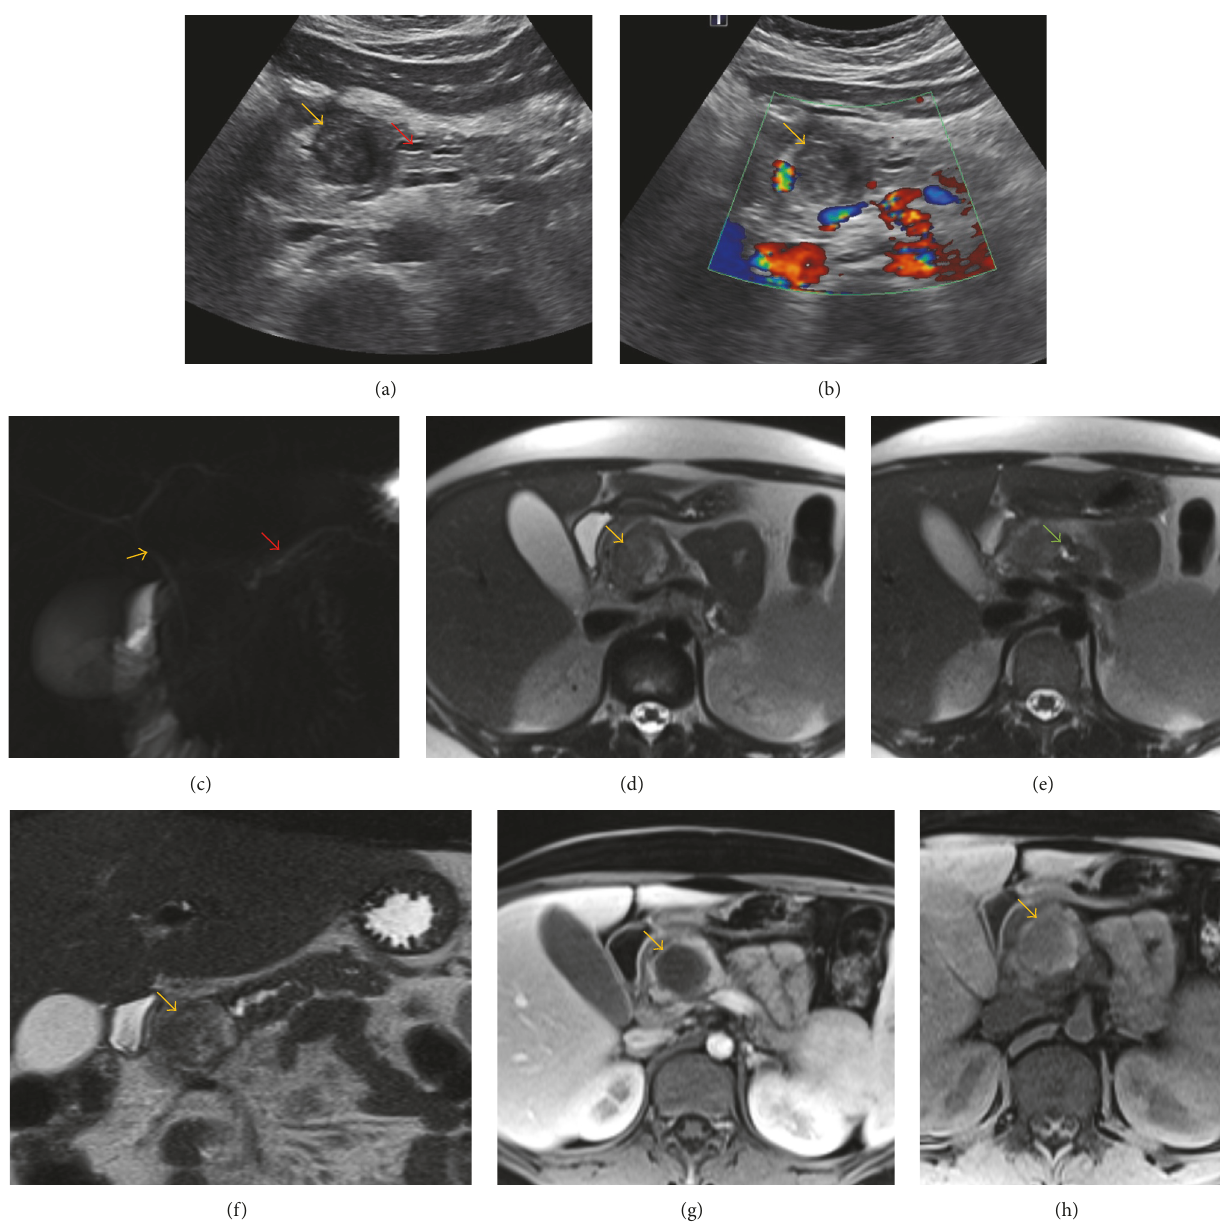
Figure 1: (a and b) Ultrasound images. (a) Well-defined hypoechoeic lesion without necrosis or calcification (orange arrow). Mildly dilated pancreatic duct (red arrow). (b) Color Doppler evaluation showing no color flow within the lesion in the pancreas (orange arrow). (c, d, e, f, g, and h) MRI and MRCP images. (c) MRCP-Normal CBD (orange arrow). Mildly dilated pancreatic duct (red arrow). (d) T2 weighted axial image showing heterogeneous mass in the head of the pancreas (orange arrow). (e) Mildly dilated pancreatic duct (green arrow). (f) Coronal T2 weighted image showing heterogeneous mass in the head of the pancreas (orange arrow). (g) Axial T1 weighted image without contrast showing well-defined hypointense lesion in the pancreas (orange arrow). (h) Axial postcontrast image showing no enhancement of the lesion in the head of the pancreas (orange